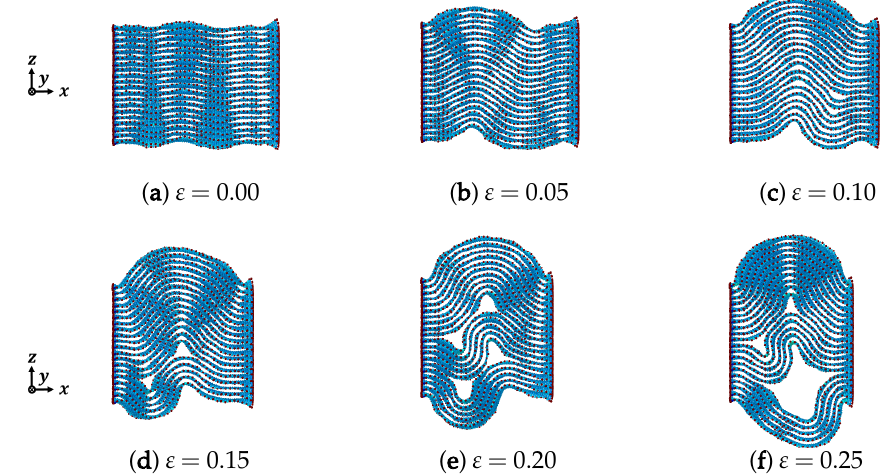
Version December 9, 2021 submitted to Nanomaterials Figure 6. Deformation of zigzag graphite under compression ( n = 20). Figure 6. Deformation of zigzag graphite under compression ( n = 20).